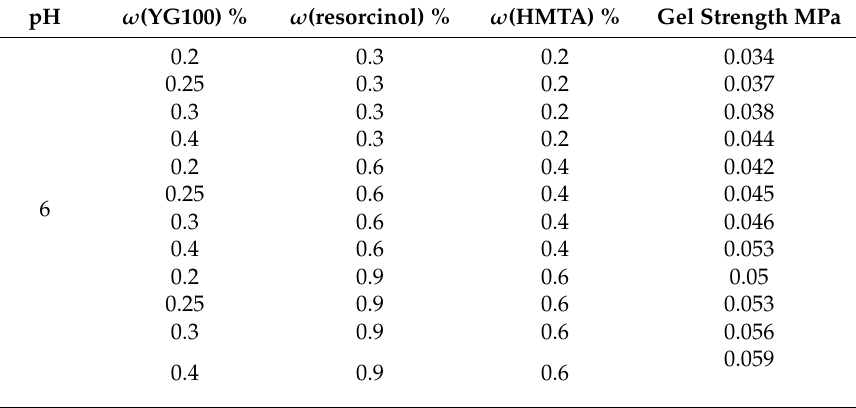
Table 1. Breakthrough vacuum value of various gel